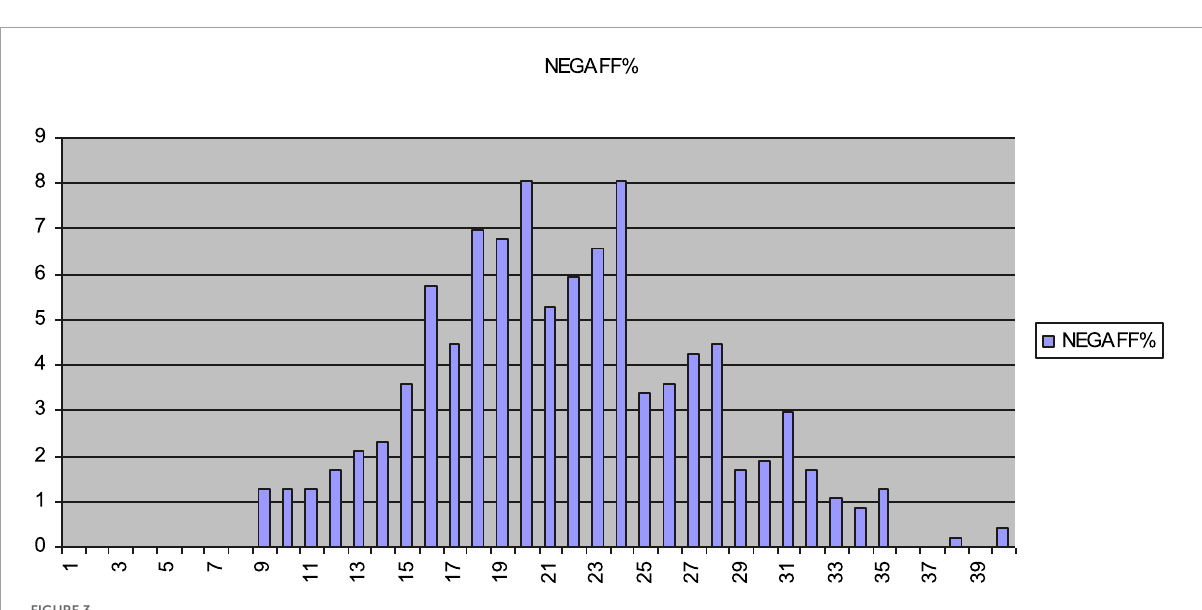
FIGURE3 Percentage of endorsement for total scores for NAS. Total scores for NAS approach a normal distribution. NAS is the negative affect